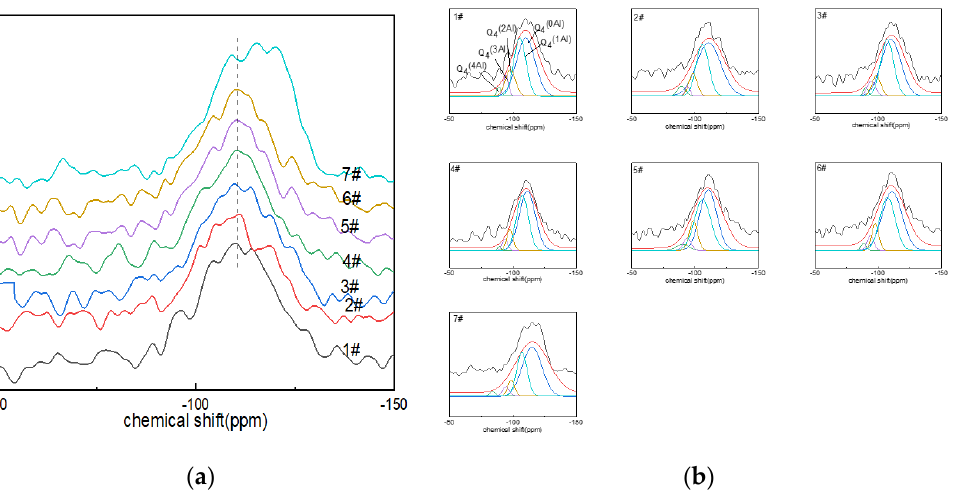
Figure 3. ( a ) 29 Si MAS NMR of Li 2 O−Al 2 O 3 −SiO 2 glass with different B 2 O 3 contents; ( b ) fitting diagram of 29 Si MAS NMR peaks of Li 2 O − Al 2 O 3 − SiO 2 glass with different B 2 O 3 contents. Table 4. Calculation results of Gaussian model fitting of 29 Si NMR spectra.